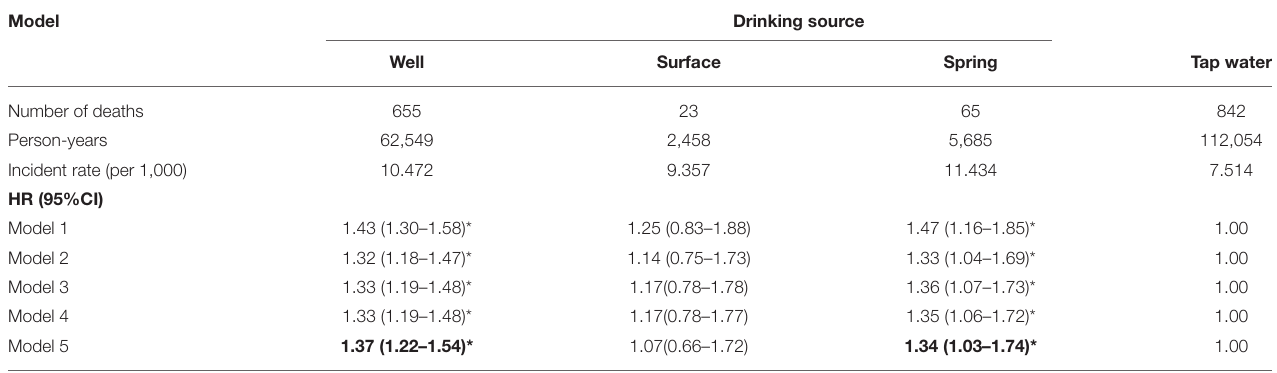
TABLE 2 | Hazard ratio (95% CI) for arthritis with drinking source.